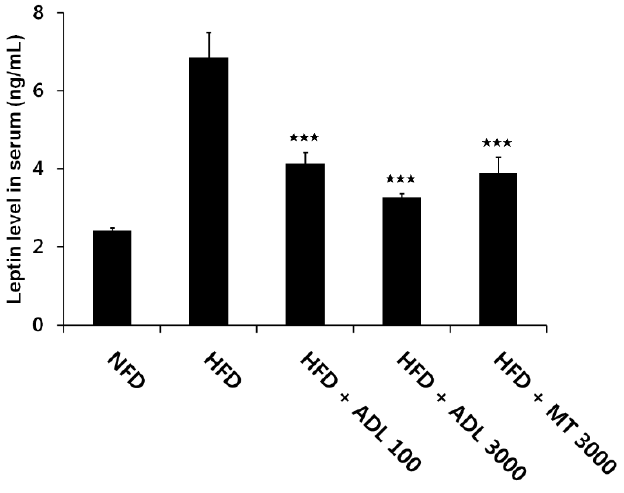
Figure 4. Effect of ADL on serum leptin. Mice were fed normal-fat diet (NFD), high-fat diet (HFD), HFD supplemented with 100 mg·kg −1 ·day −1 ADL (HFD + ADL 100), HFD supplemented with 3000 mg·kg −1 ·day −1 ADL (HFD + ADL 3000), and HFD supplemented with 3000 mg·kg −1 ·day −1 yerba mate (HFD + MT 3000) for 6 weeks. Serum samples were obtained from 15 h-fasted mice. Leptin was assayed by ELISA. Bars represent mean ±